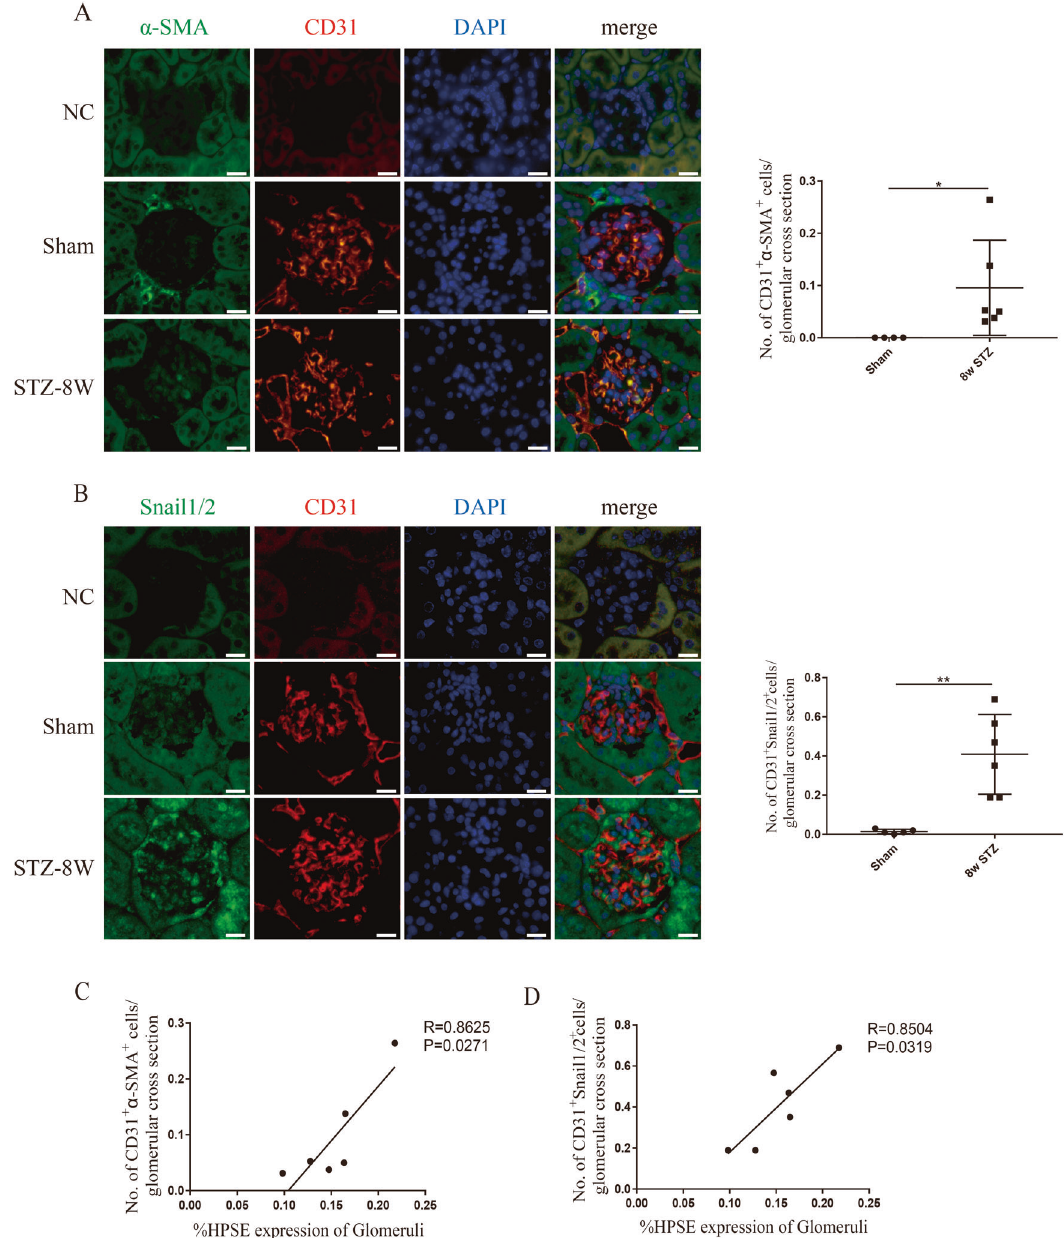
Fig. 2 HPSE had a positive correlation with EndMT of GEnCs in STZ-induced diabetic mice. The counts of double positive IF staining for CD31- α -SMA ( A ) and CD31-Snail1/2 ( B ) were markedly high in STZ-induced diabetic mice. Pearson correlation analysis exhibited that HPSE was positively correlated with the numbers of double positive staining for CD31- α -SMA ( R = 0.8625, P = 0.0271) ( C ) or CD31-Snail1/2 ( R = 0.8504, P = 0.0319) ( D ) respectively. Scale bar = 10 μ m. Each vertical bar represents the mean ± SD ( n = 4~6) analyzed by two-tailed t -tests test. * P < 0.05, ** P < 0.01, and *** P < 0.001. signaling molecule in high glucose or HPSE-mediated EndMT of diabetic GEnCs. DISCUSSION EndMT is a process similar to the better understood epithelial- mesenchymal transition (EMT), in which endothelial cells show an acquired mesenchymal characteristics and loss of endothelial features. This phenotypic change has been implicated in development and several pathologic conditions such as cancer, transplant, atherosclerosis and organ fi brosis [3, 11]. In the kidney